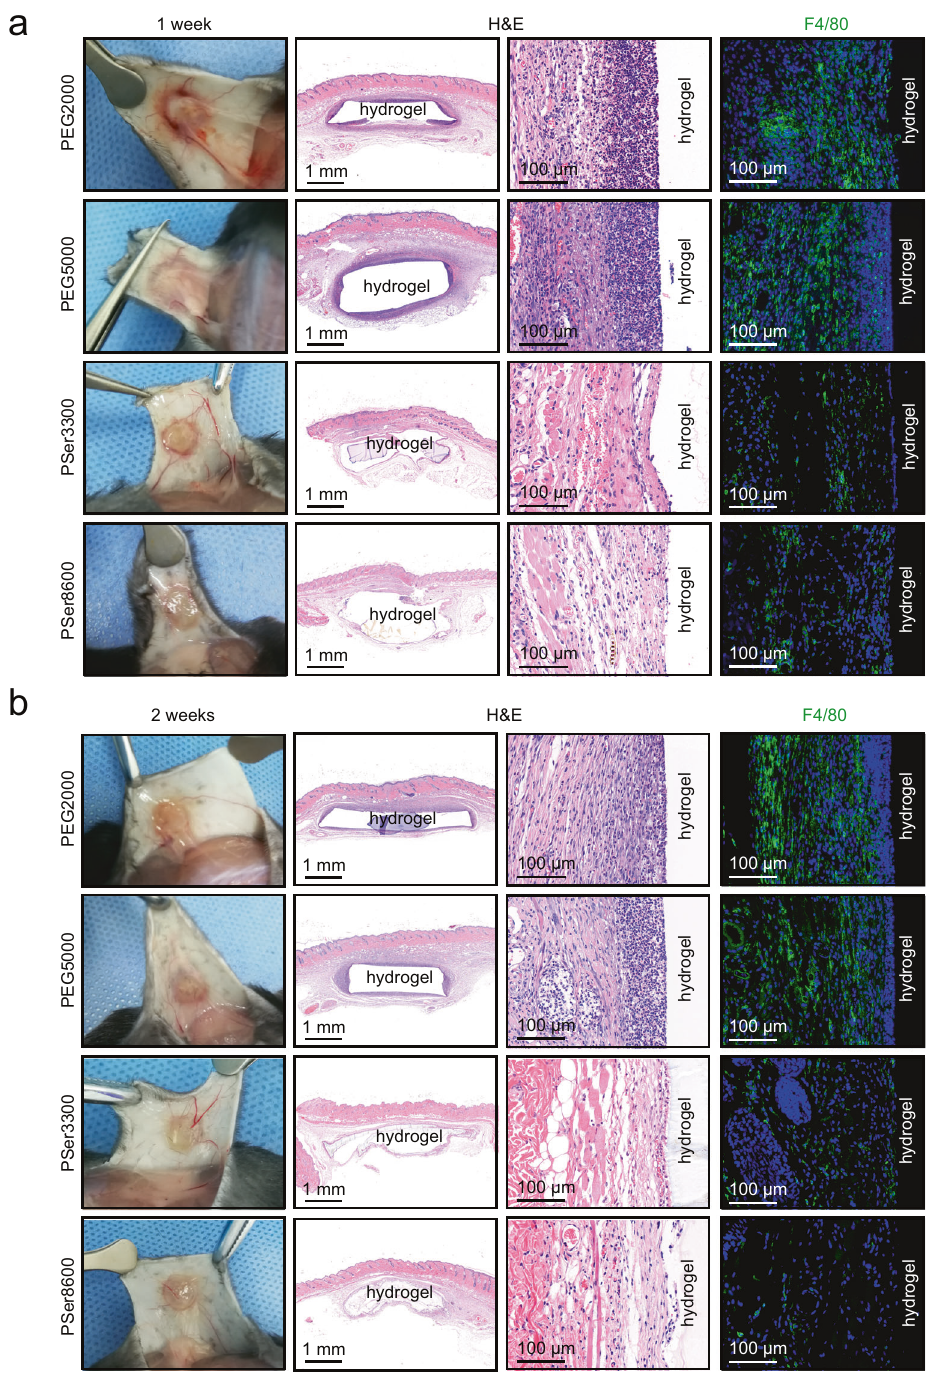
Fig. 3 In fl ammatory response in tissues surrounding the PEG and PSer hydrogels. Explantation and staining images of PEG and PSer hydrogels after subcutaneously implanted in mice for 1 week ( a ) and 2 weeks ( b ). PEG hydrogels visually were observed to be blurry and full of cell and tissue deposition, while PSer hydrogels were observed to be more transparent and devoid of cellular deposition. The in fl ammatory response to the implants were evaluated by a hematoxylin-eosin (H&E) stain. Macrophages were labeled by pan macrophage immuno fl uorescent biomarker (F4/80) and were stained in green fl uorescence. Nucleus were stained by DAPI to show blue fl